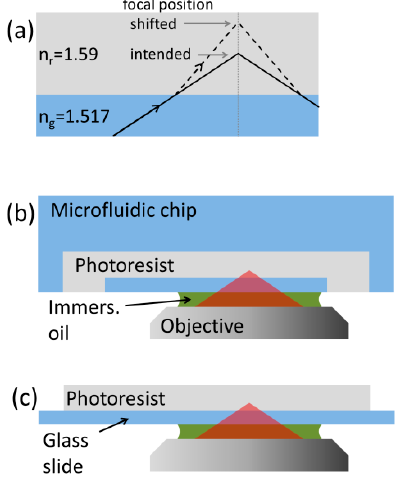
Figure 1. Focusing of a laser beam into a photoresist with a high NA objective. Panel ( a ) shows the marginal ray of the strongly focused beam passing through parallel, refractive-index mismatched layers. A possible scheme of TPP inside a microfluidic channel ( b ) and its model system on a microscope cover slide ( c ).